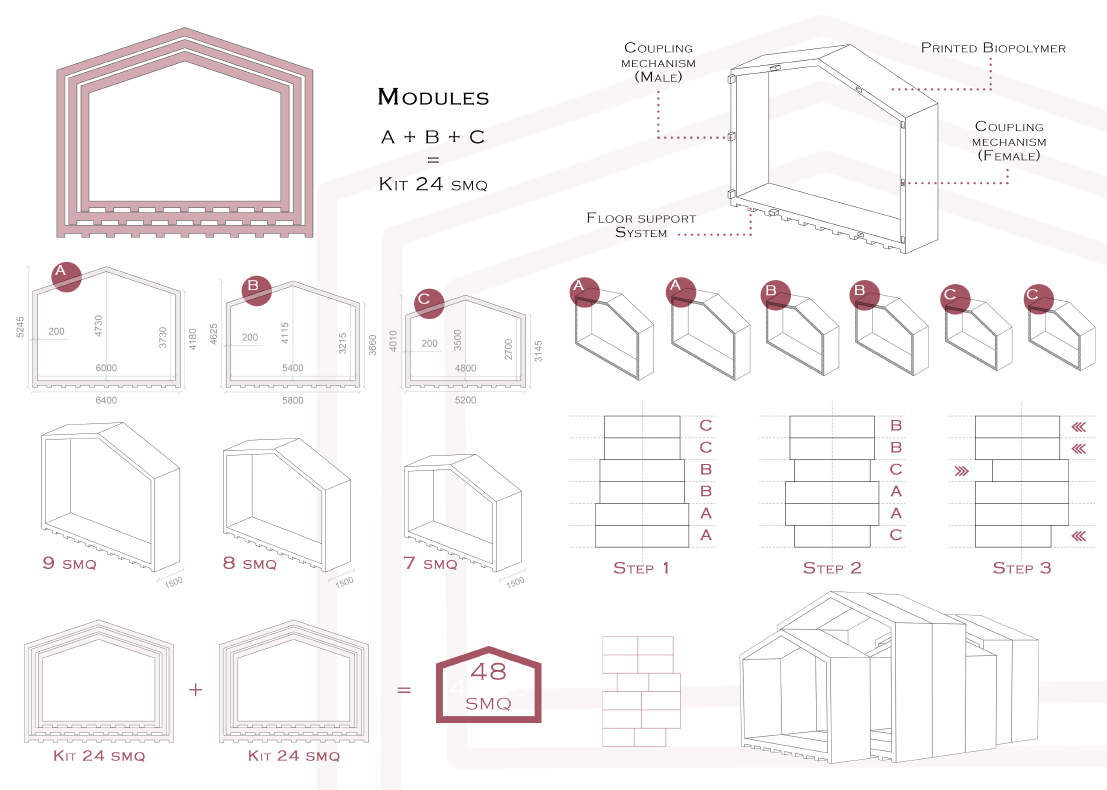
Figure 2. Composition diagram, MoDom circular housing